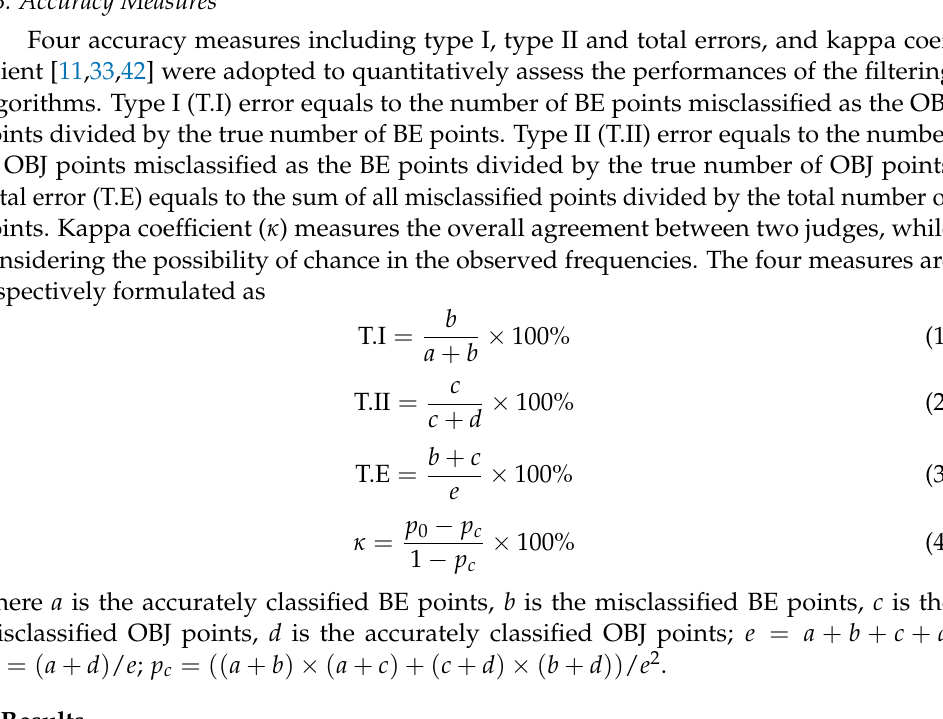
Figure 8. Reference DEMs of the six datasets ( a – f ). Plots 2–3 are more complex than the other plots, and plots 4–6 have steep slopes.